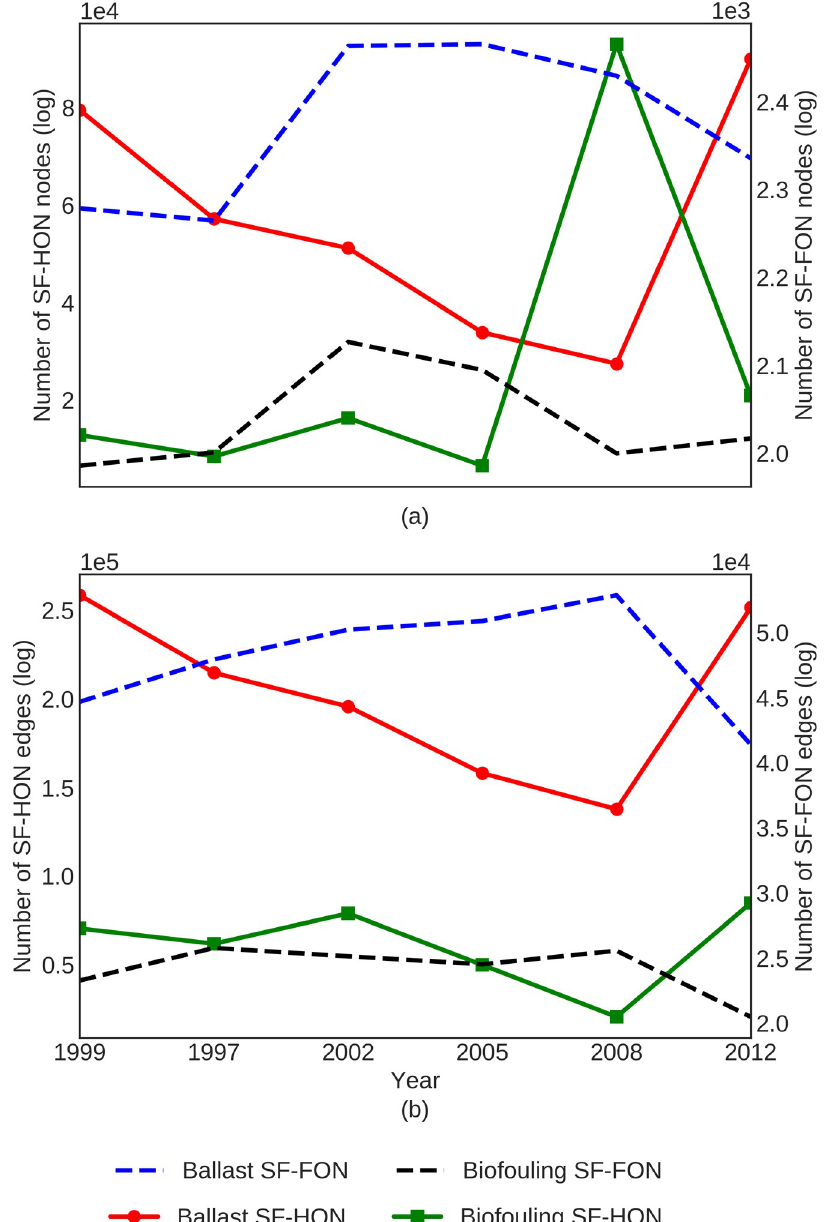
Fig 6. SF-HONs show significantly larger changes in both number of nodes (a) and edges (b) compared to AquaNIS and NEMESIS datasets (S2 Table in S1 File). In NAS data, the difference between SF-HON and All-Paths predictions is statistically significant ( p -value = 0.036), but for SF-HON and SF-FON the difference was not significant ( p -value = 0.147). Overall, biofouling SF-HON improves the predictions of NIS spread significantly compared to All-paths and SF-FON. While ballast SF-HON’s predictions on average results in more accurate predictions,